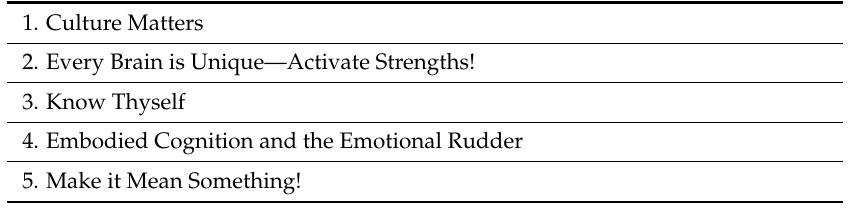
Table 2. Five key ideas from neuroscience: Guiding a multiple intelligences-inspired education.